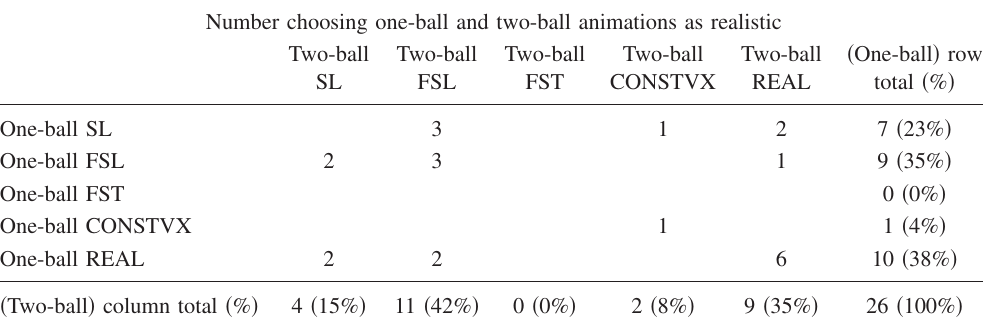
TABLE III. Animation preferences for one- and two-ball tasks; 26 students from an educational psychol- ogy